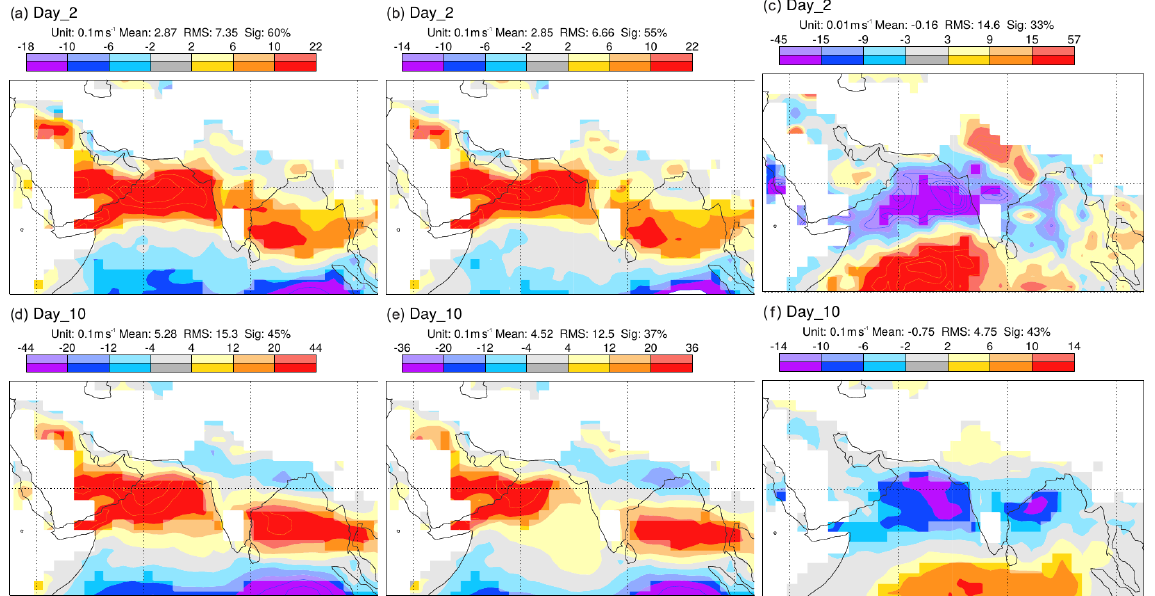
Figure 12. Near-surface (925hPa) zonal wind for the period 1 May–21 August 2016 over the northern Indian Ocean for (a–c) forecast day 2 and (d–f) forecast day 10. Model bias using (a, d) TG97, (b, e) CAMS climatology and (c, f) the difference between forecasts using the CAMS climatology and TG97 climatology. Notice the different scale in the righthand side panels. Bold colours indicate areas significant at the 5% level using a paired t test with AR(1) noise. The units are indicated above each